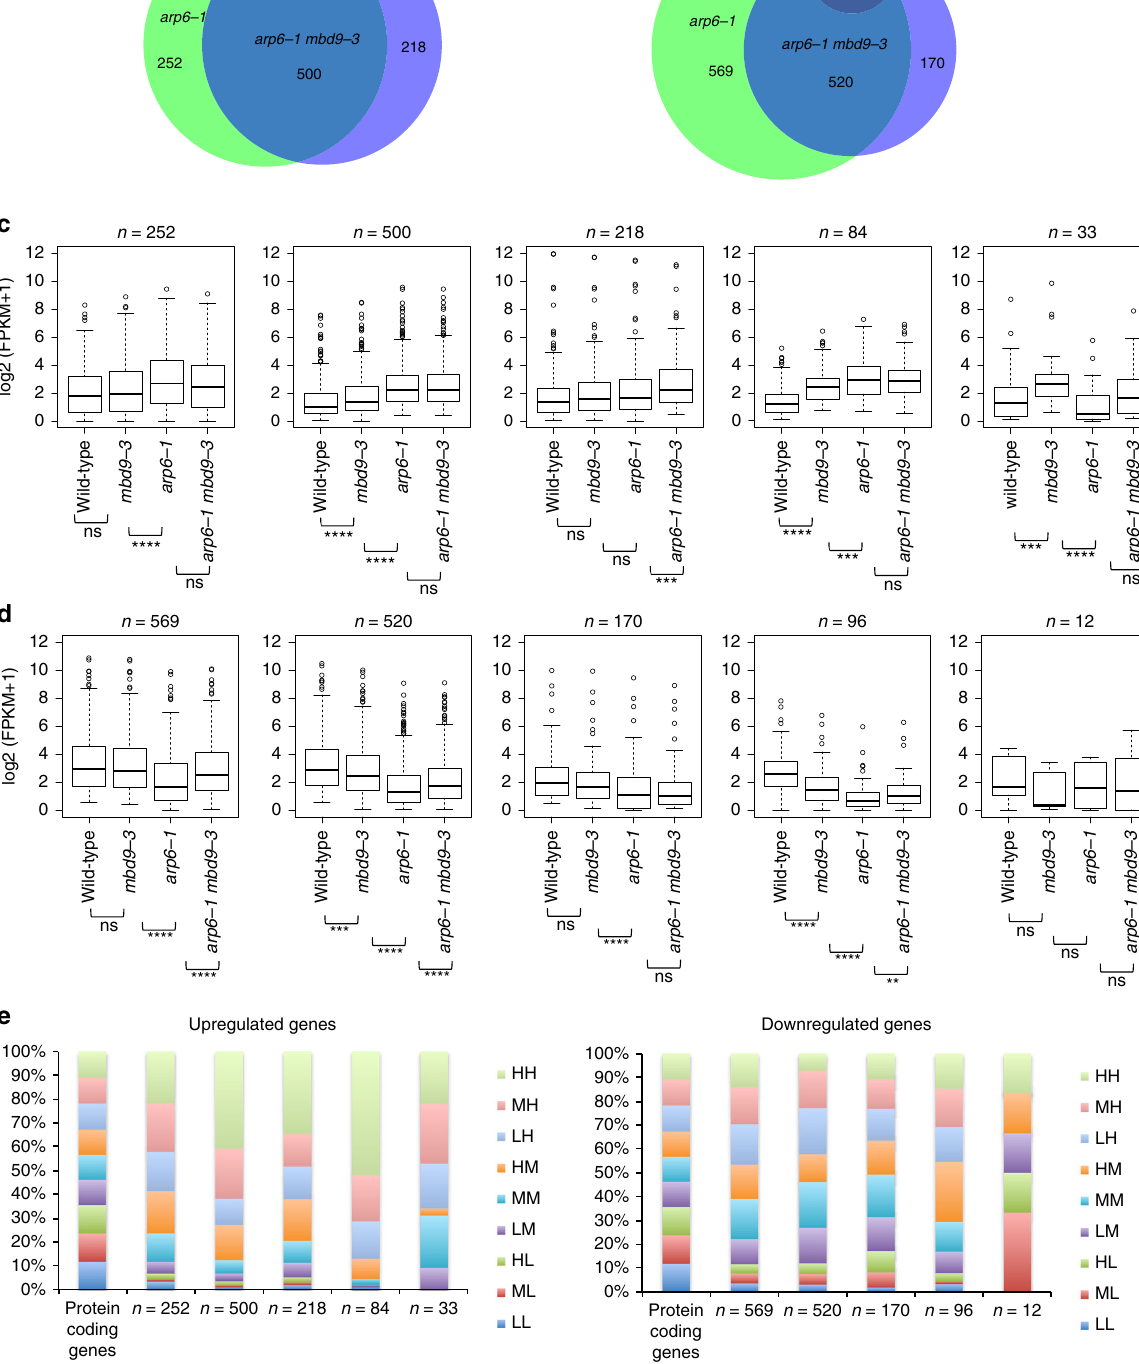
We further investigated MBD9 occupancy in relation to H2A.Z distribution. When plotting H2A.Z over MBD9-occupied genes, we detected a loss of H2A.Z at the 5 ′ -ends of genes in the mbd9-3 mutant (Fig. 4f). To investigate whether the loss of H2A.Z occurs over a speci fi c subset of genes, we ordered MBD9-occupied genes based on H2A.Z occupancy in the wild type using k